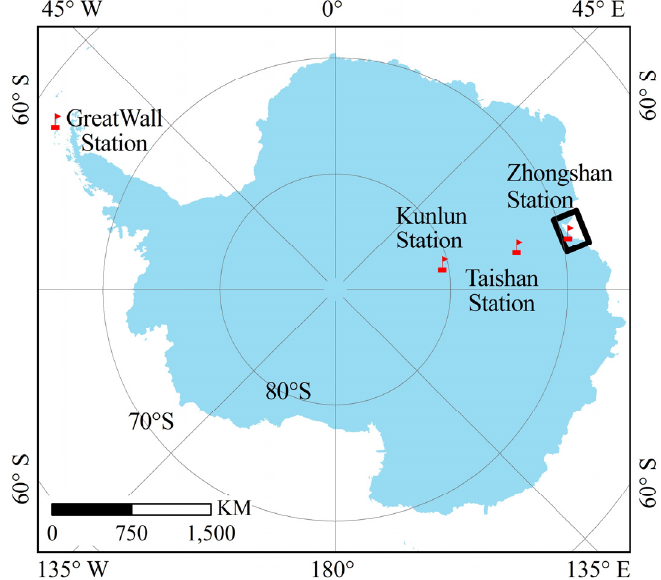
Figure 1. Map of the Antarctica showing the four Chinese stations. The black box over Zhongshan Station show Prydz Bay where the study was conducted.